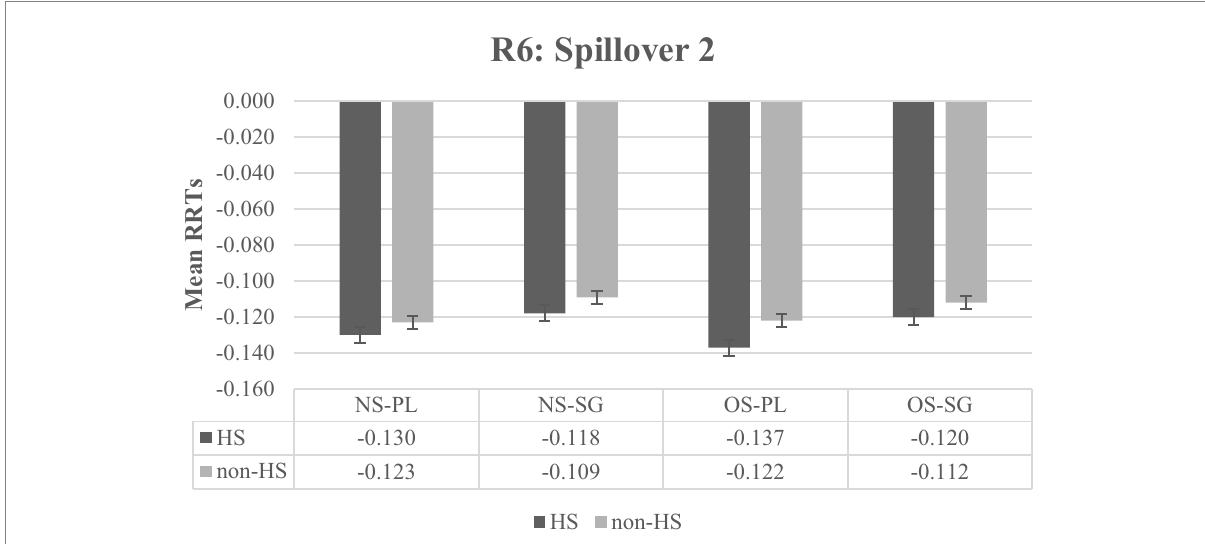
FIGURE 4 Mean RRTs of both groups for Region 6 (Spillover 2). RRTs, Residual reading times; HS, Heritage speakers; non-HS, Non-heritage speakers; NS, Null subject; OS, Overt subject; PL, Verb is plural-marked; SG, Verb is